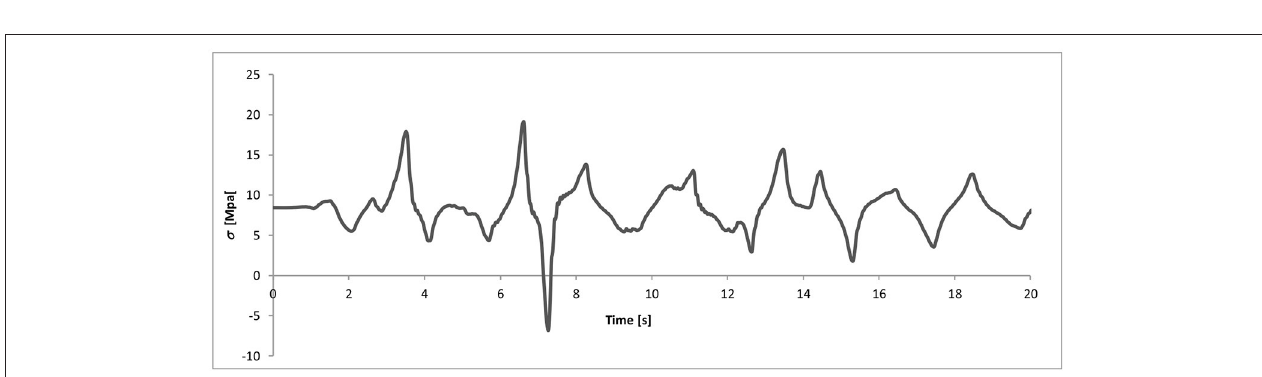
FIGURE 11 | Time history of the axial force (in terms of stress) of device #2, used for computing the device response to variable axial force depicted in Figure 13 .